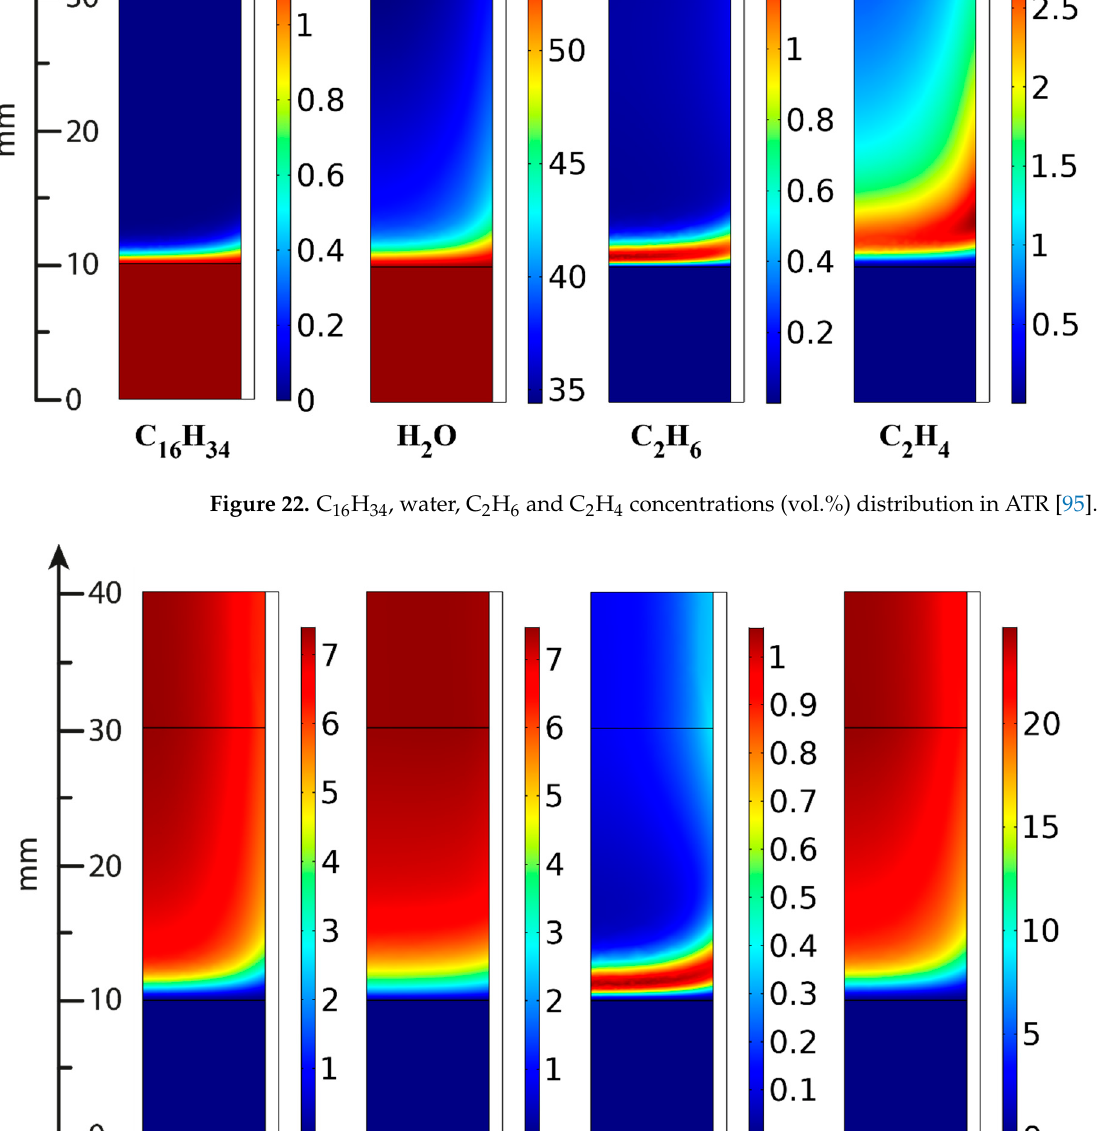
Figure 23. CO, CO 2 , CH 4 and H 2 concentrations (vol.%) distribution in ATR